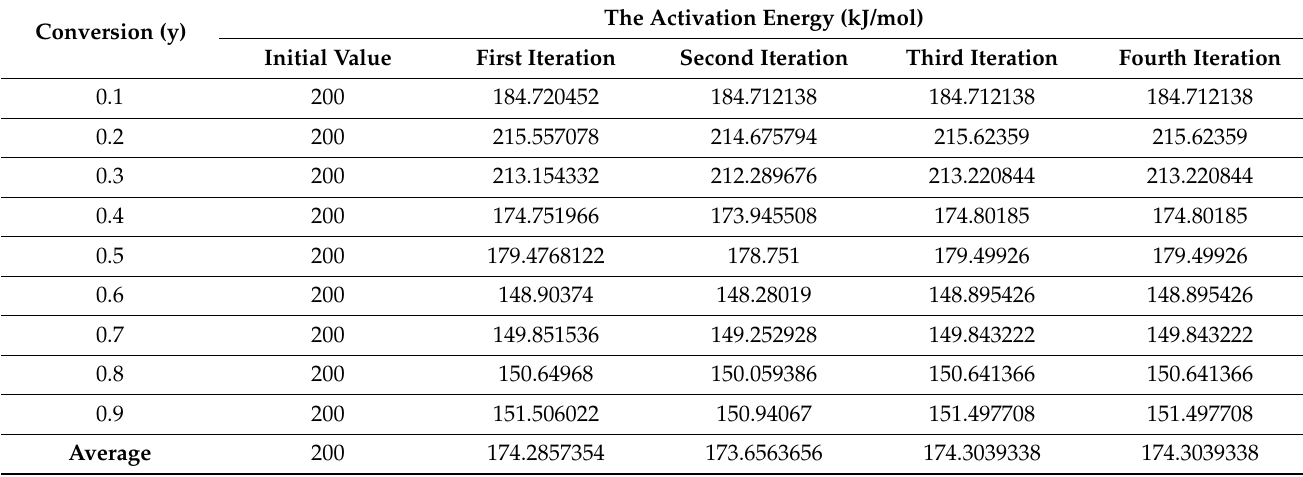
Table 7. The calculated activation energy using the Cai method at different number of